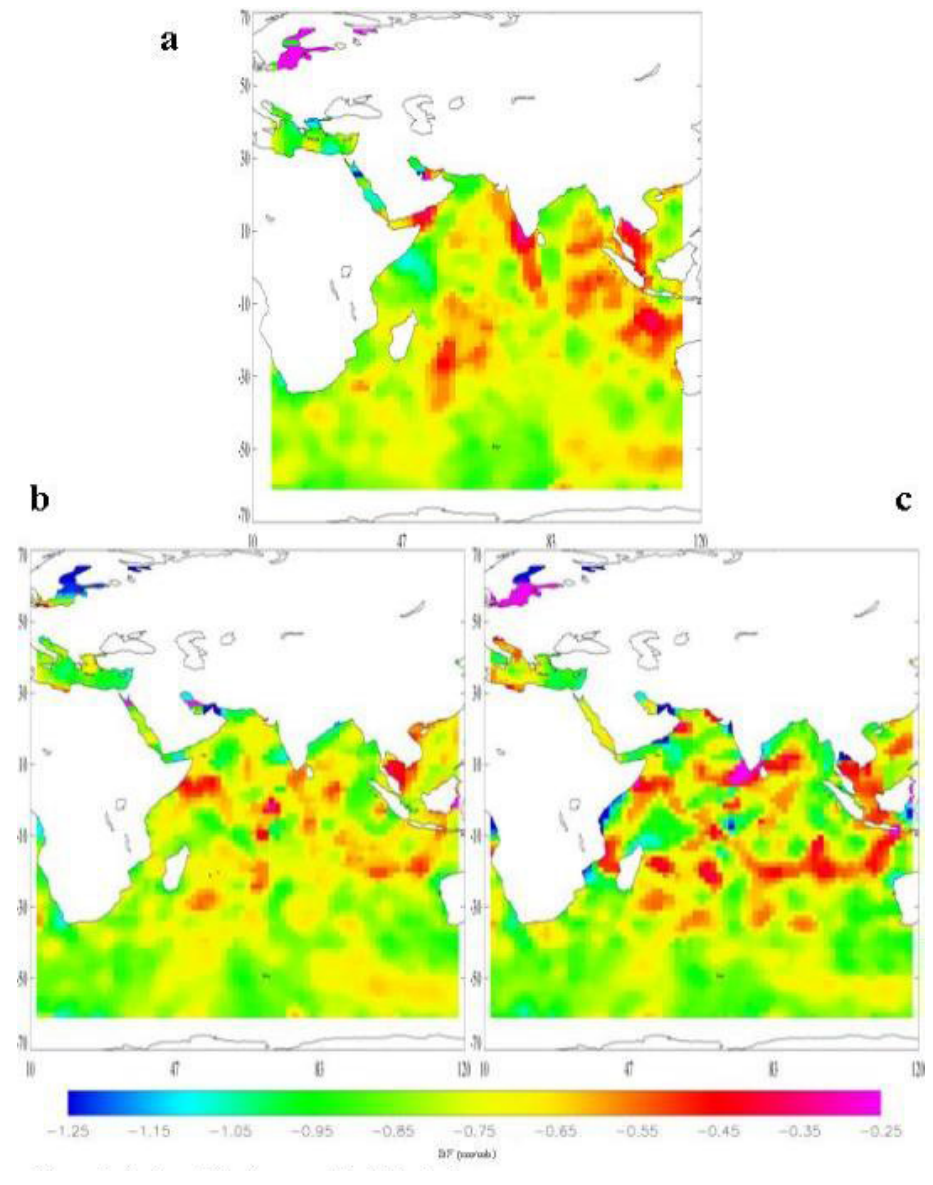
Fig. 5. As Fig. 3, in the case of the Indian